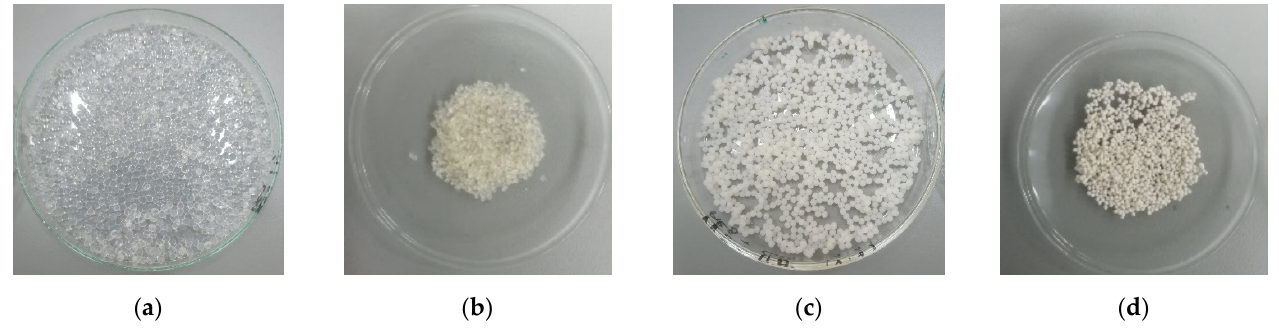
Figure 2. The appearance of ALG (wet—( a ), dried—( b )) and ALG–BPA (1:1) (wet—( c ), dried—( d )) microbeads.